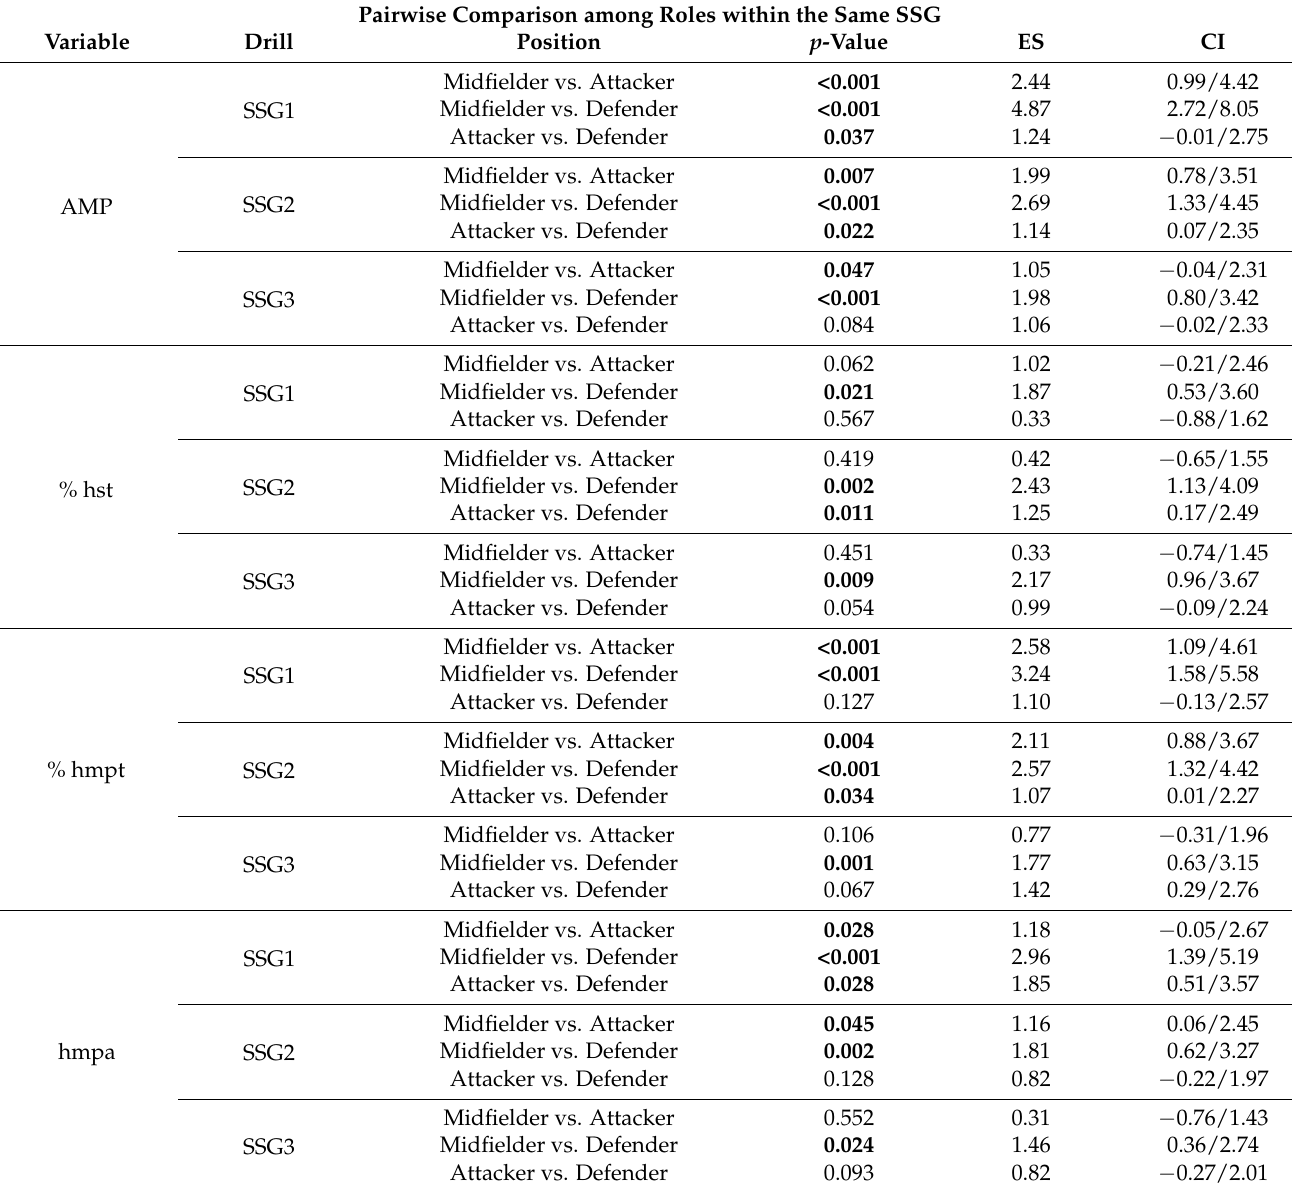
Table 4. Pairwise comparison of recorded variables among roles within the same SSG and among SSGs within the same positional role and. p values, effect sizes and confidence intervals are